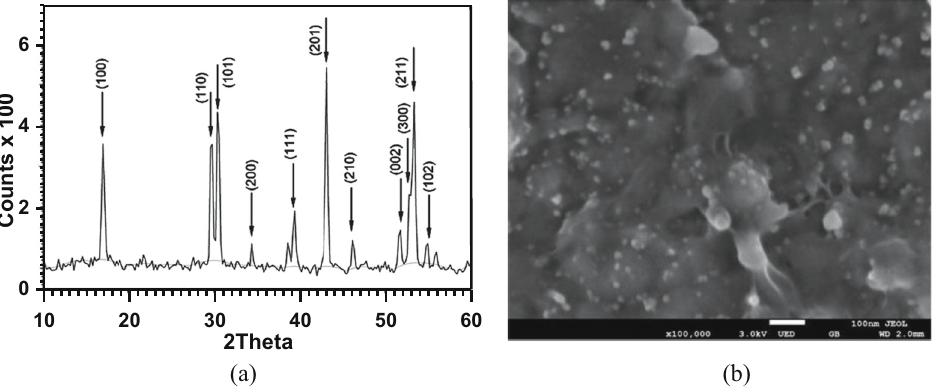
Figure 14: ( a ) XRD spectrum of the polymer nanocomposite fi lm made of PMMA and the nanoparticles of NaYF 4 :Yb 3 + ,Er 3 + with the di ff raction peaks attributed to the hexagonal β - phase of NaYF 4 . ( b ) High - resolution SEM image of the polymer nanocomposite fi lm of PMMA +